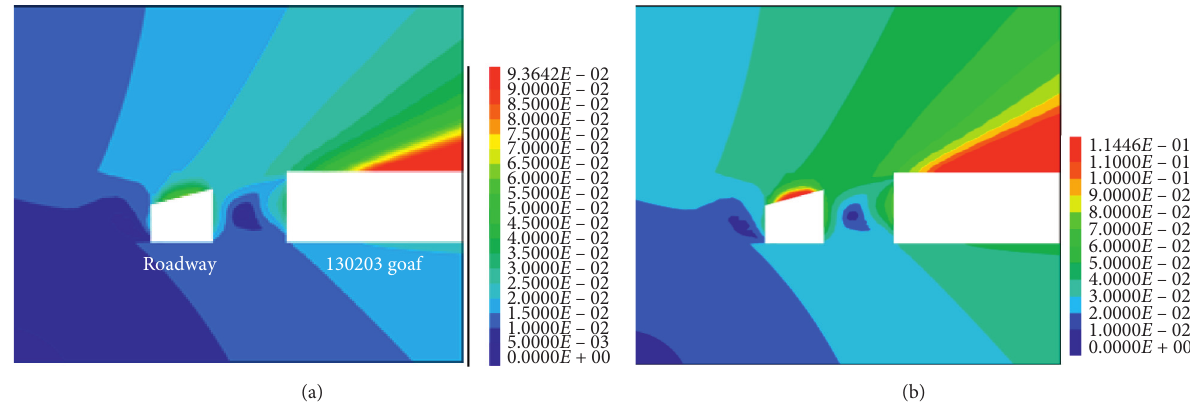
Figure 6: Nephograms indicating the rock deformation during airway excavation. (a) 150m from the cutting hole and (b) 180m from the cutting